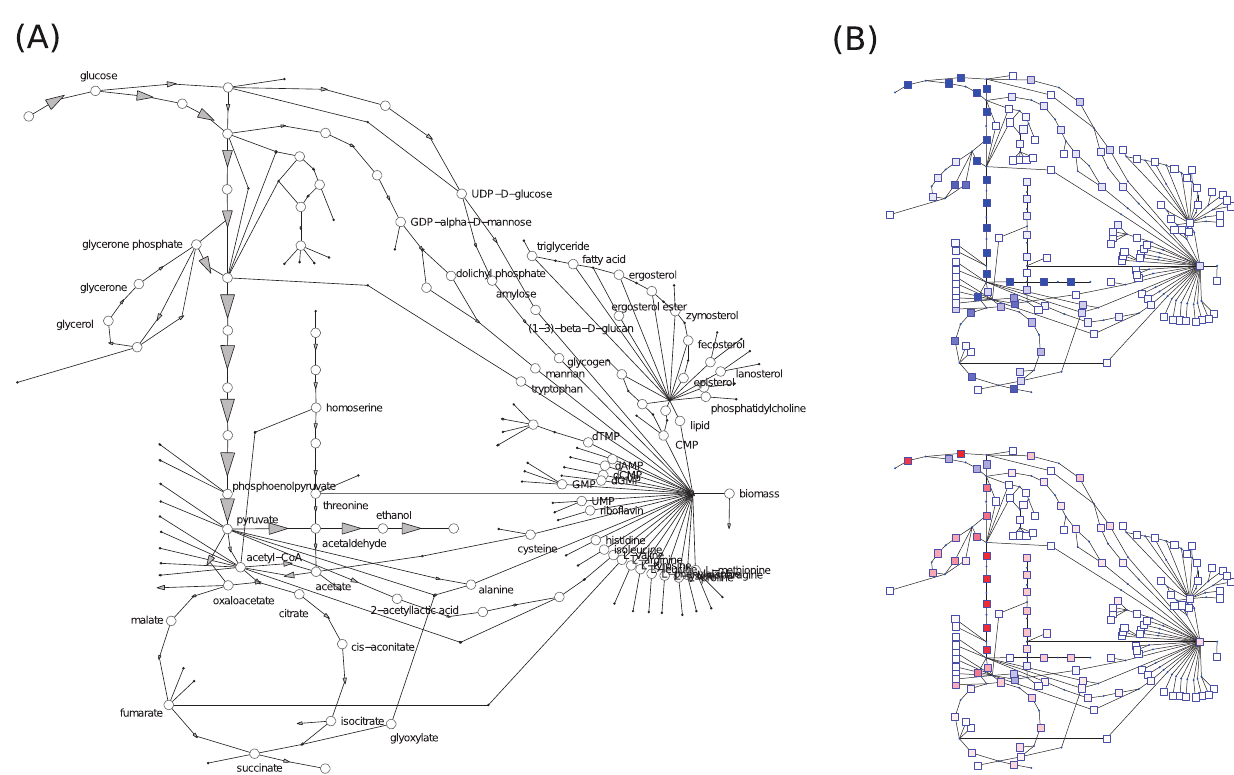
Figure 3. Fluxes and control coefficients in the yeast metabolic model. (A) Fluxes obtained from Geometric FBA. Only selected reactions with large fluxes are depicted, co-substrates are not shown (flux directions and magnitudes shown by arrows). (B) Flux control coefficients. Top: Control exerted by the glucose transporter (GluT). Unscaled flux control coefficients are shown in shades of blue (positive values) and red (negative values). Bottom: control exerted by the biomass production reaction. High-flux reactions respond most strongly: an increased glucose import increases the glycolytic flux, while increased biomass production directs fluxes to other pathways and thereby decreases the glycolytic flux. Flux control coefficients for a model with allosteric regulation are shown in Figures G and H in File